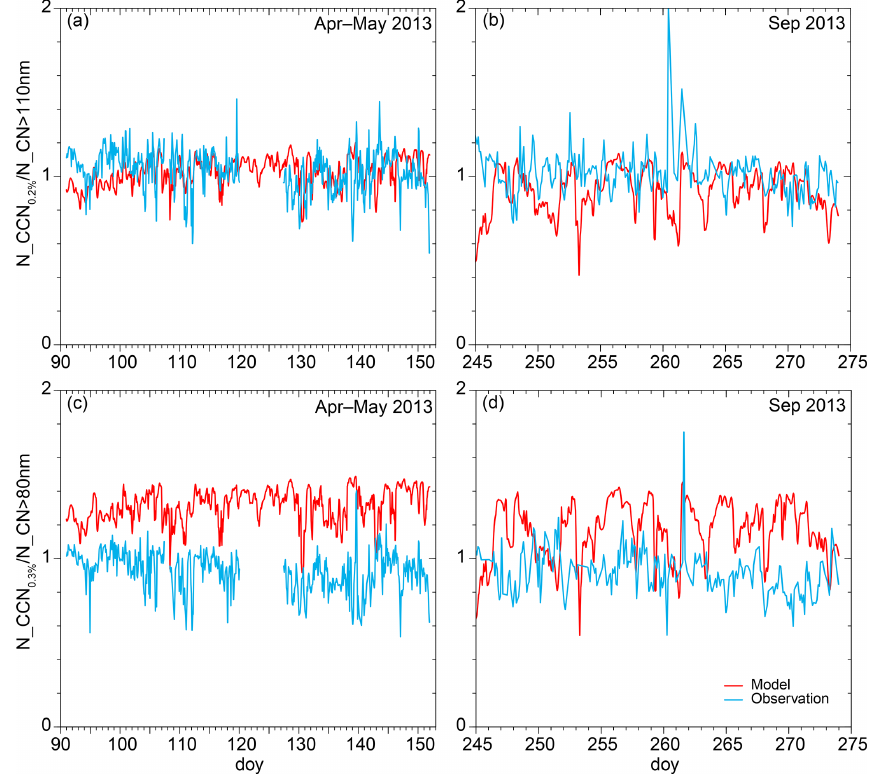
Figure 4. Comparison of the modeled and observed activated fraction (N_CCN/N_CN) at a supersaturation of 0.2% (a, b) and 0.3% (c, d) , respectively. For the number of total CN, the number concentration of CN > 110nm (a, b) and > 80nm (c, d) , respectively, was used.